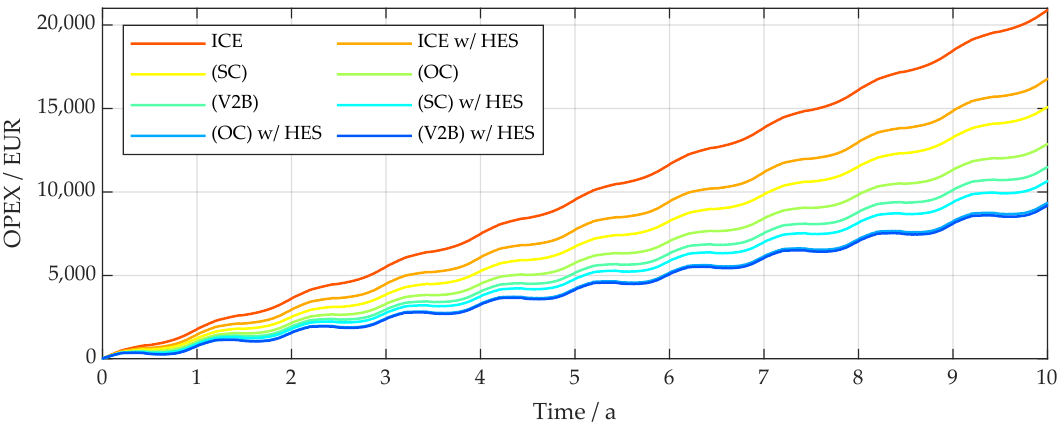
Figure A1. Operating expenses (OPEX) during ten years of operation showing a strong seasonal